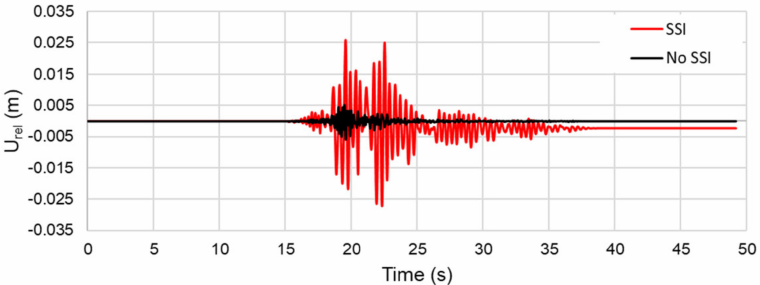
Figure 7. Comparison between the relative horizontal displacement time-histories obtained by the two models, for the seismic input n. 1 (F a = 1.5).